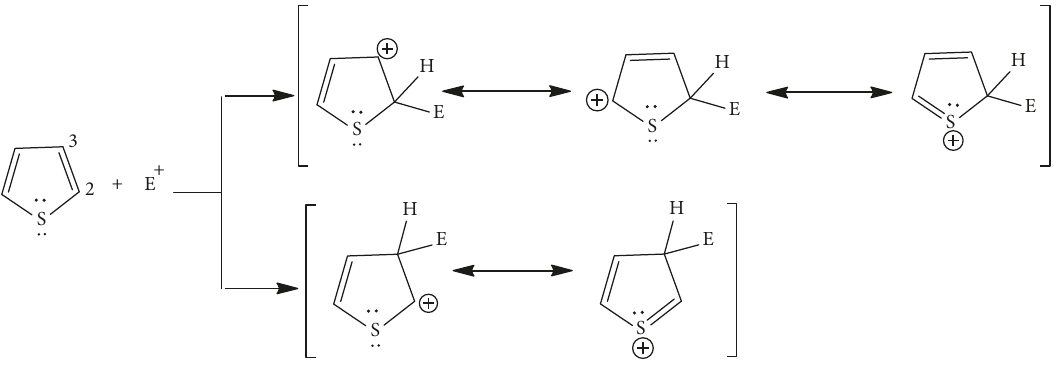
Scheme 1: Resonance stabilization of 2-substitution intermediate is greater than that of the 3-substitution intermediate.